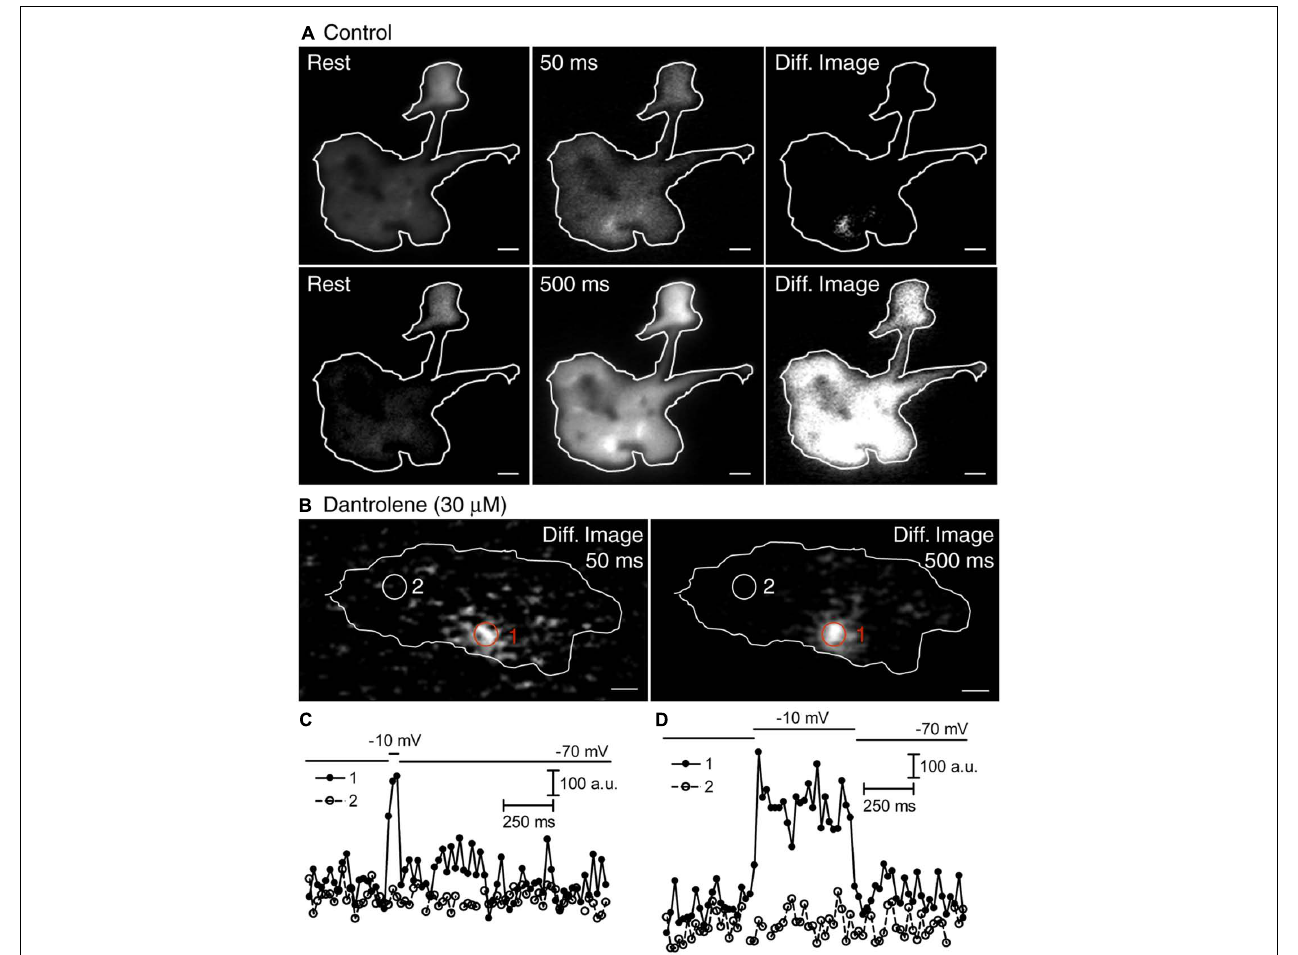
FIGURE 3 | Spread of submembrane Ca 2 + during sustained depolarization is due to CICR. Rods were loaded with fluo-5F (100 μ M) through a patch pipette (A,B) . Submembrane [Ca 2 + ] i changes were monitored using a 488-nm laser underTIRFM at 21.3 ms/frame (A,B) . (A,B) Rods were voltage clamped and depolarized from − 70 to − 10 mV for 50 or 500 ms. Resting images were obtained by averaging 19 images before depolarization. Depolarized images were obtained by selecting one frame during 50-ms steps or by averaging 21 image frames during 500-ms steps. Difference images were generated by subtracting the resting images from the images during depolarization.The rod in (A) shows that a 50-ms depolarizing step applied under control conditions stimulated localized